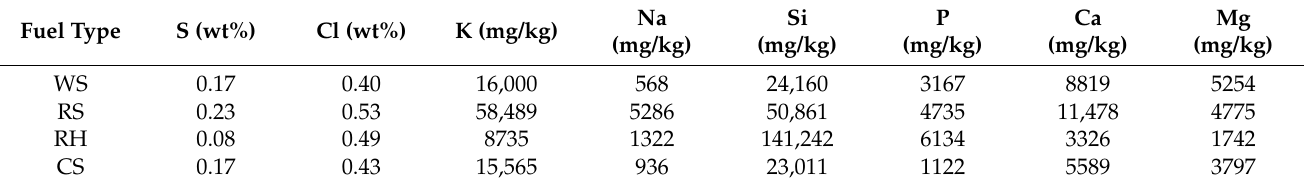
Table 5. Fuel properties of individual agricultural crop